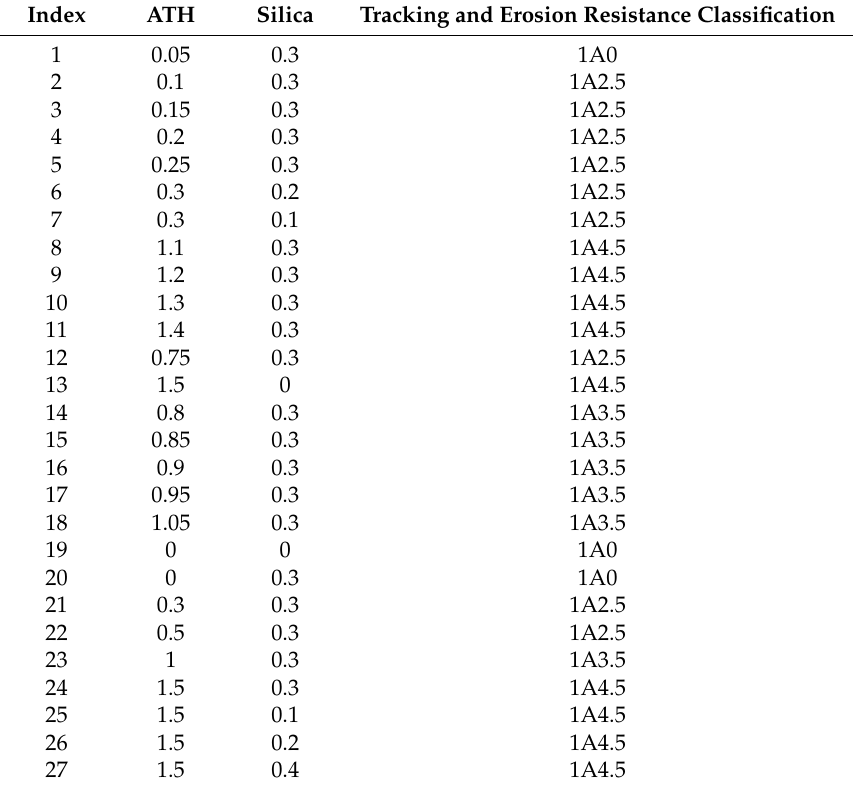
Table 4. The results of the inclined plane test for all the samples.